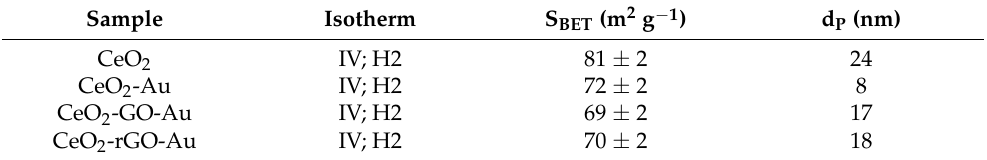
Table 2. Textural properties: type of N 2 isotherms, BET surface area and mean pore